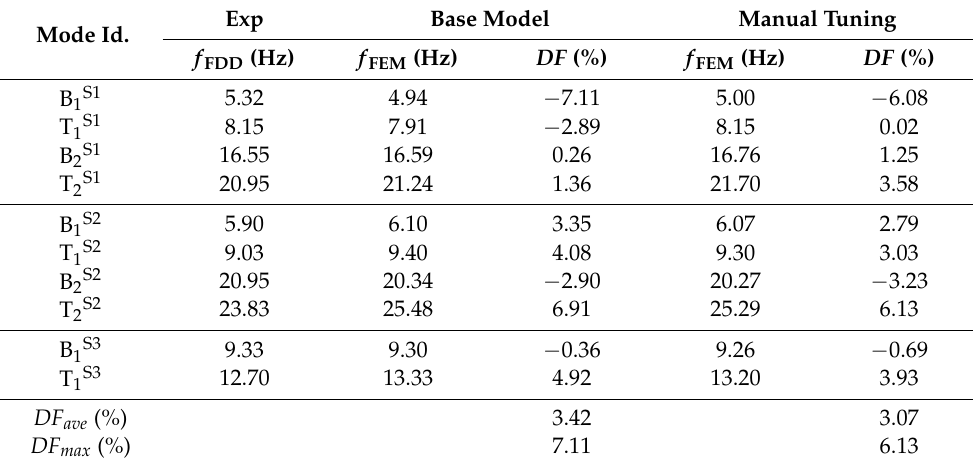
Table 3. Comparison between experimental and numerical frequencies. Mode Id.